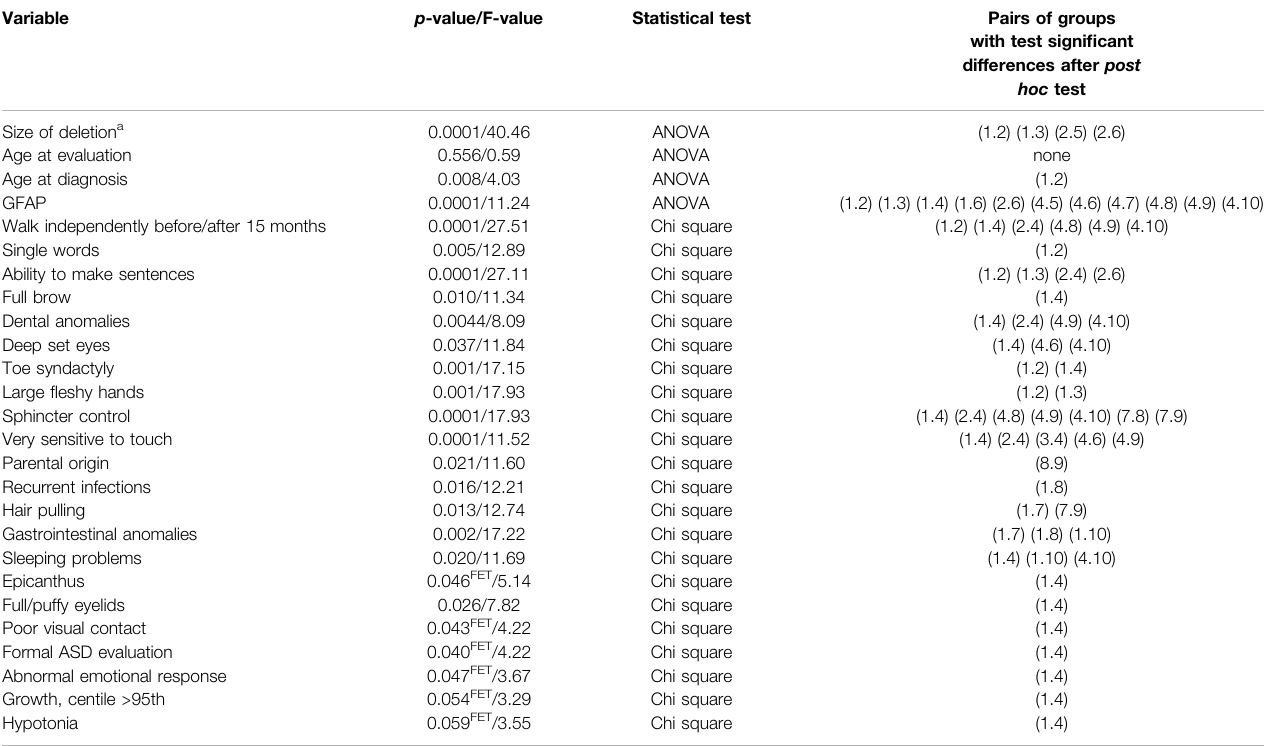
TABLE 5 | Comparison between groups with different types of genetic alterations.